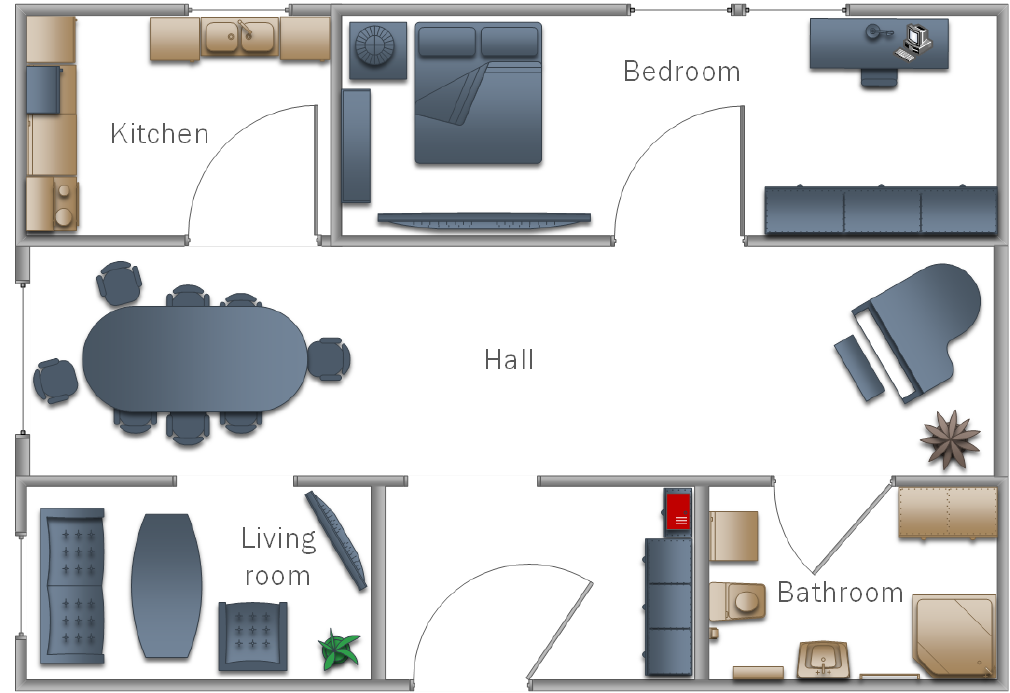
Figure 9. A model of the home that was used in testing proposed model in Experiment